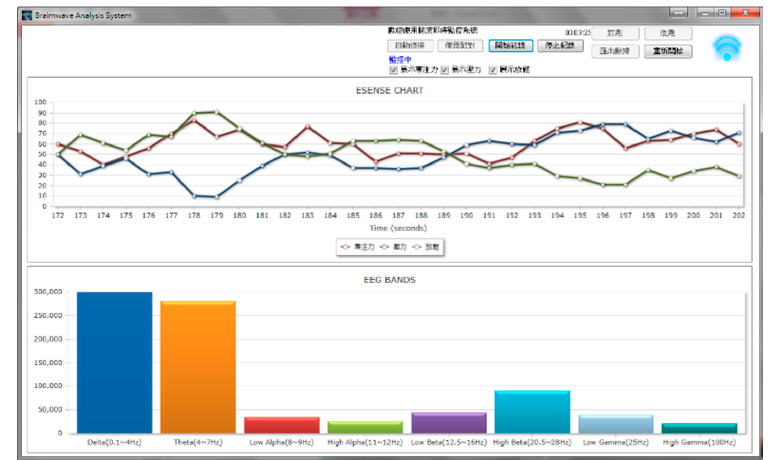
Figure 3. Screenshot of the real-time electroencephalogram (EEG) monitoring system.